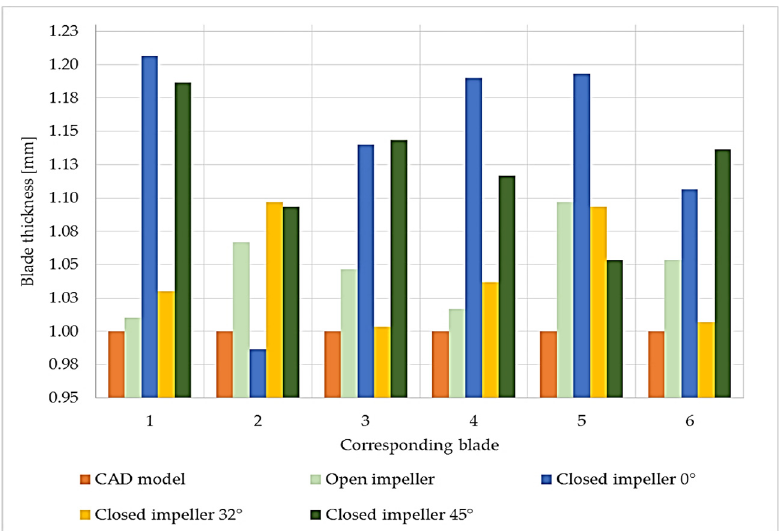
Figure 9. Blade thickness values measured using a caliper with an average of 3 values with respect to computer-aided design (CAD)